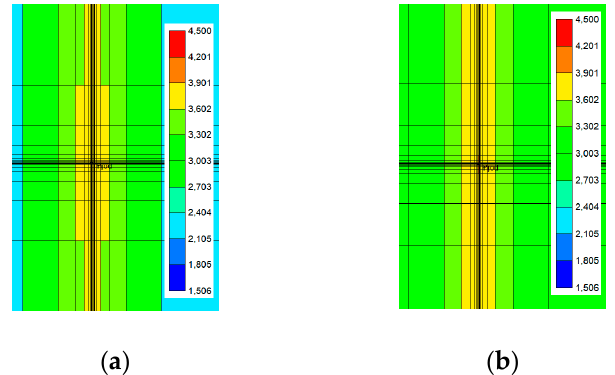
Figure 16. Pressure distribution. ( a ) Injection time: 50 days; ( b ) Injection time: 100 days.